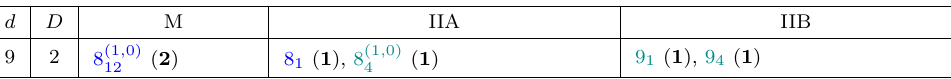
Table 15 . Branes in the 8-brane